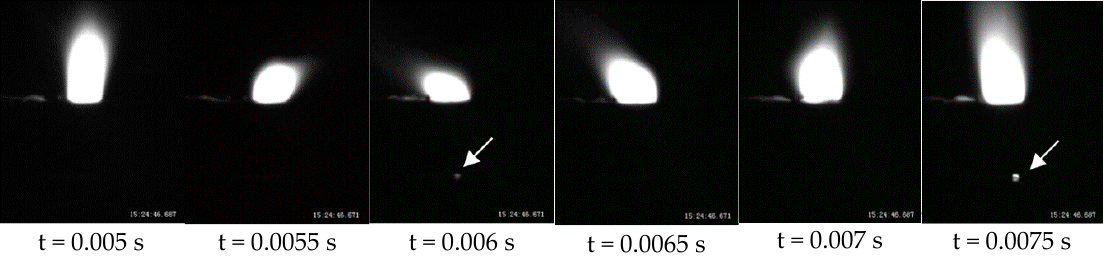
Figure 6. The plasma pattern under the gap presence of 0.2 mm.